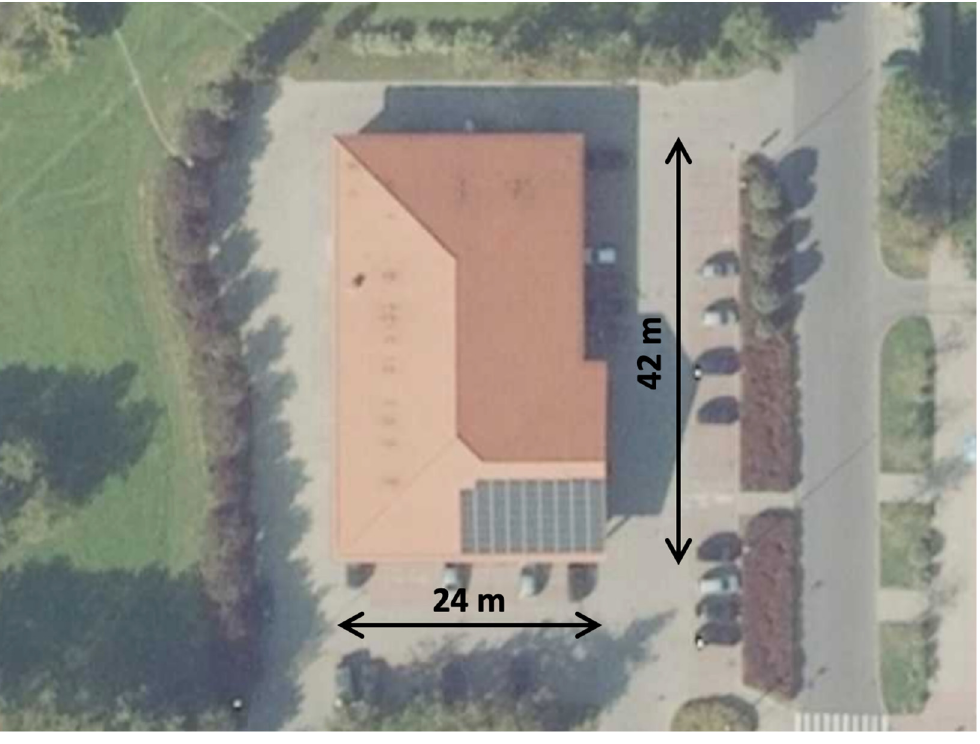
Figure 3. Object of research—retail and service building.